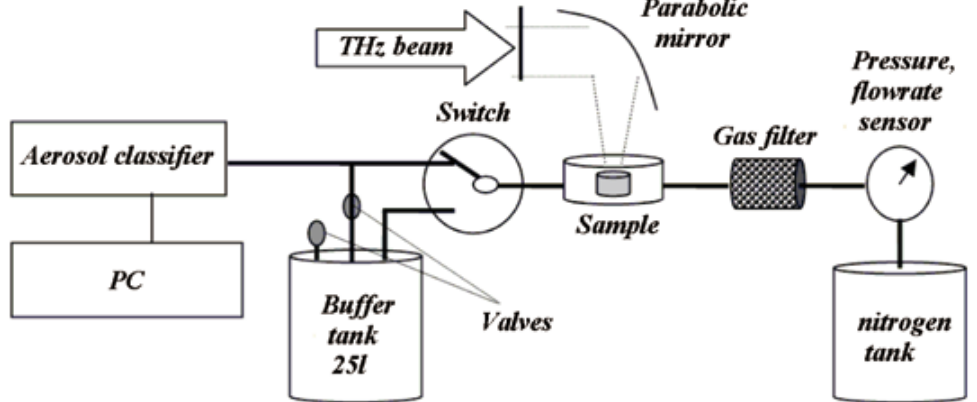
Fig. 2 Schematic of an experimental